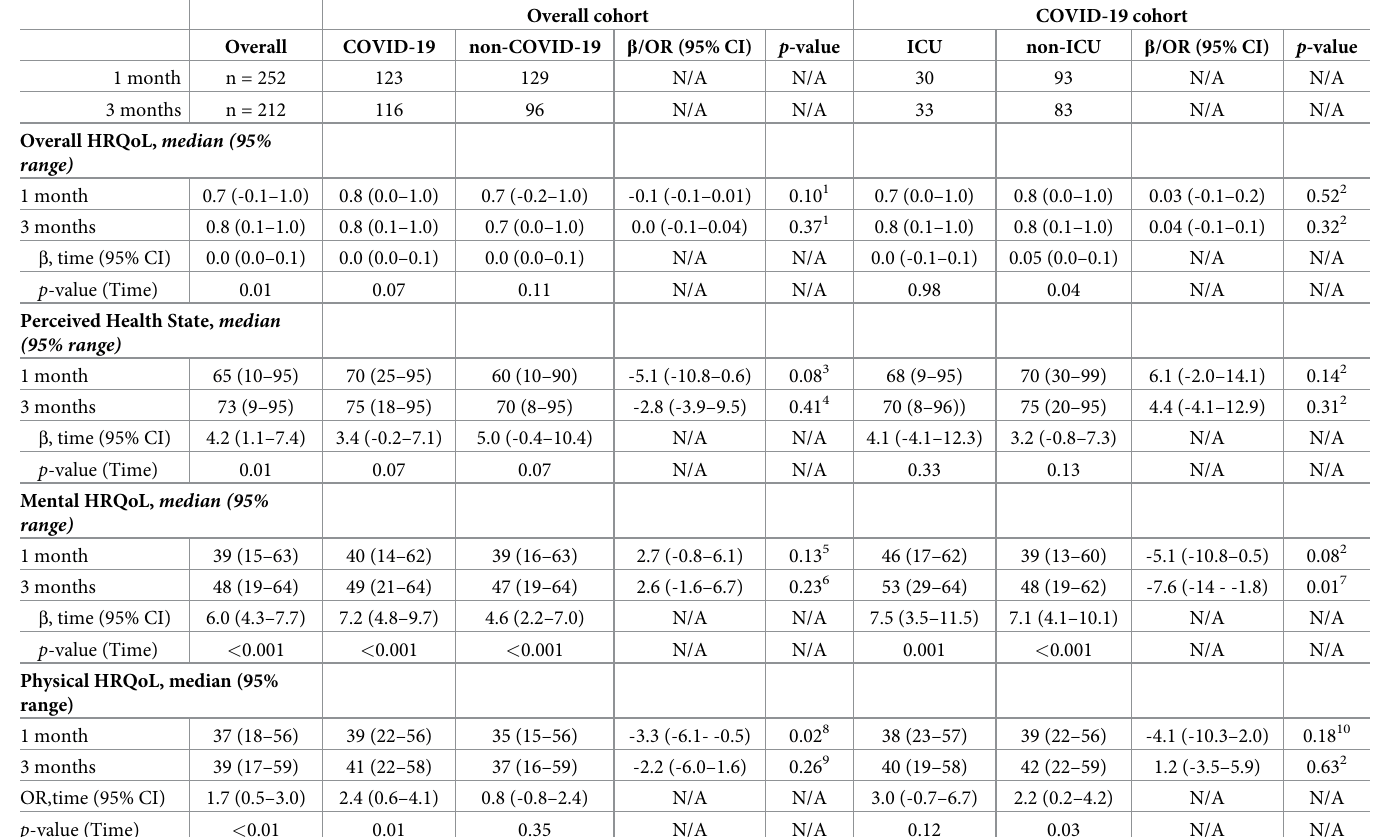
Table 3. Health-related quality of life throughout